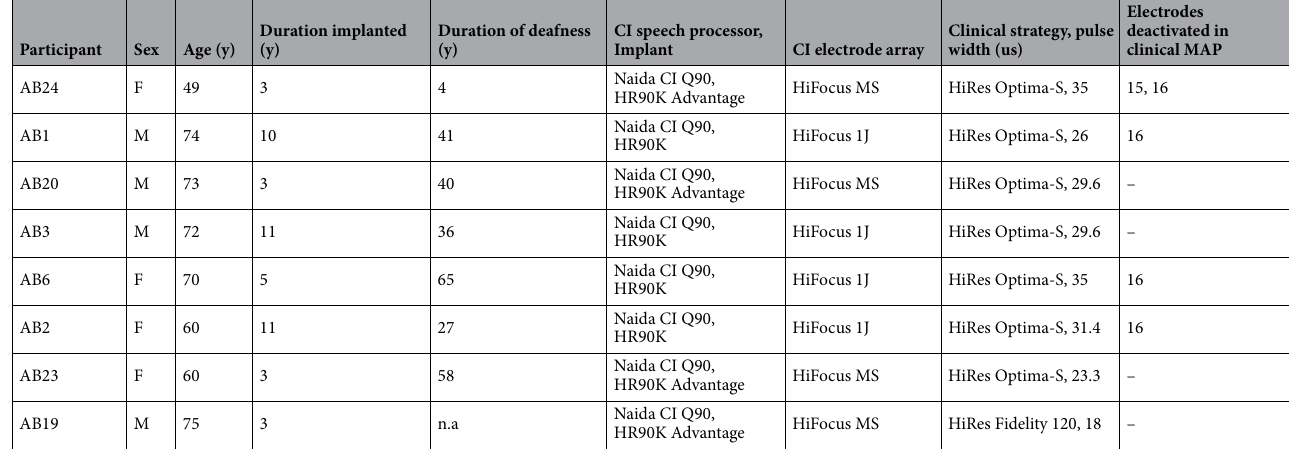
Table 1. Participant demographic information and clinical CI